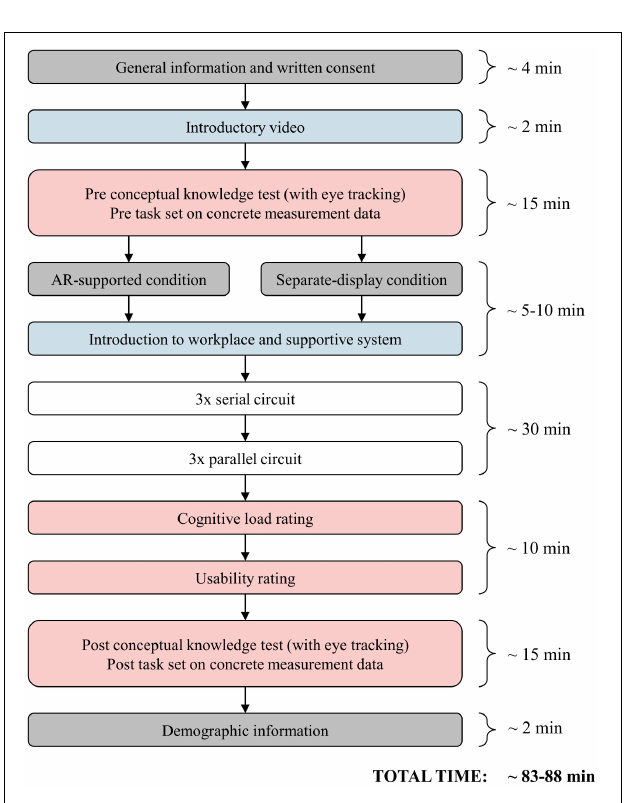
FIGURE 7 | Experimental